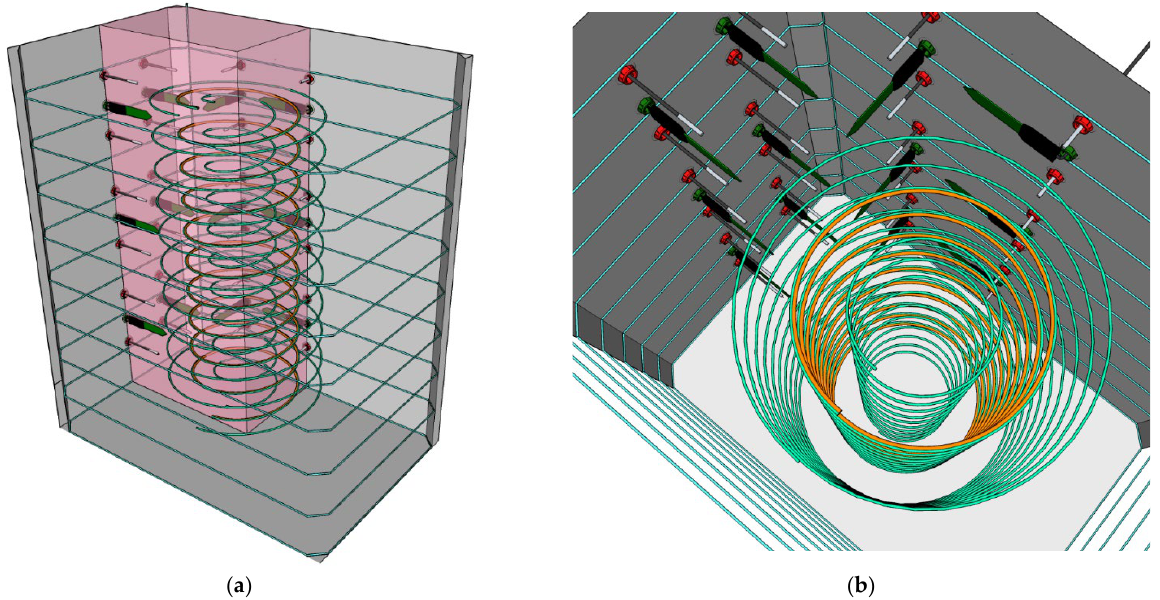
Figure 3. Rendering of the container experiment setup. Isometric side view ( a ) and top view ( b ). Figure 4 shows how the sensors were aligned during the filling of the container. On the left side (Figure 4a) two PT1000 sensors and on the right side (Figure 4b) moisture sensors SMT100 are